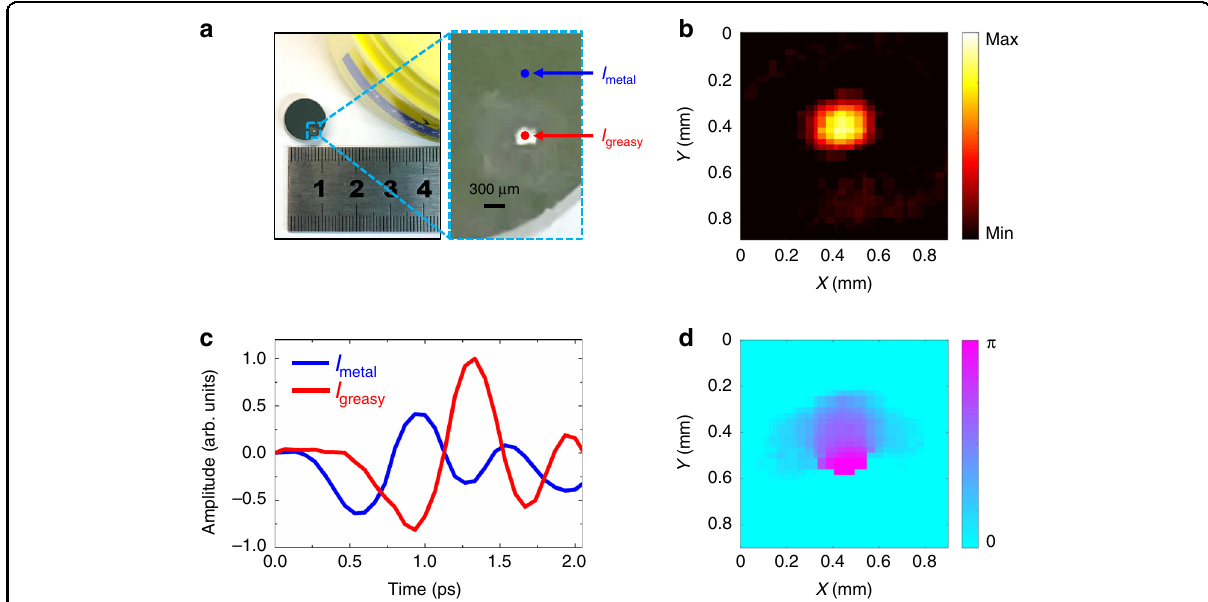
Fig. 6 THz near- fi eld imaging of a greasy spot. a Greasy spot (Vaseline cream) on a metallic mirror, and a ruler. A magni fi ed view shows the 300 µm diameter of the spot. The positions of the I metal and I greasy THz signals are marked by blue and red points on regions of the mirror and the spot. c THz temporal signals of I metal and I greasy . Intensity and phase images of the spot at 1.0 THz are presented in b and d ,